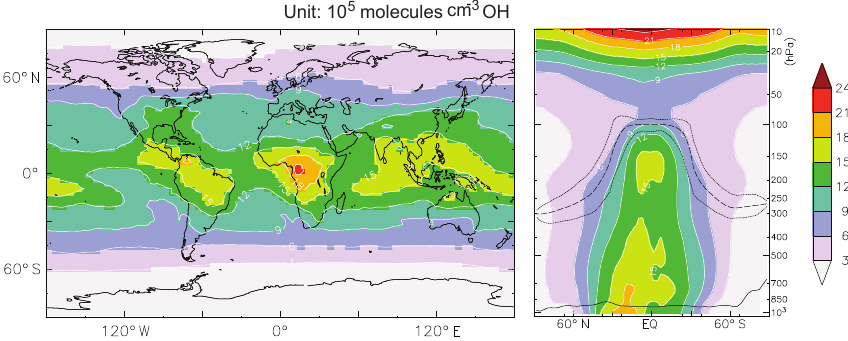
Figure 1. Global OH in 10 5 moleculescm − 3 . Left: tropospheric, annual mean. Right: zonal annual mean up to 10hPa. The lower solid line indicates the average boundary layer height, the upper dashed line the mean tropopause and the solid lines the annual minimum and maximum tropopause